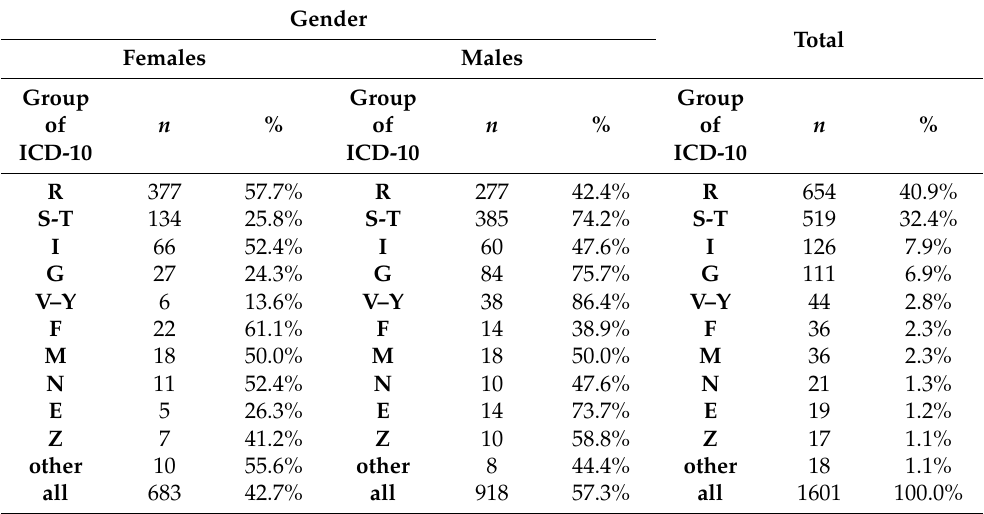
Table 3. ICD-10 diagnosis groups used by emergency medical services teams to make diagnoses during workplace interventions depending on gender.